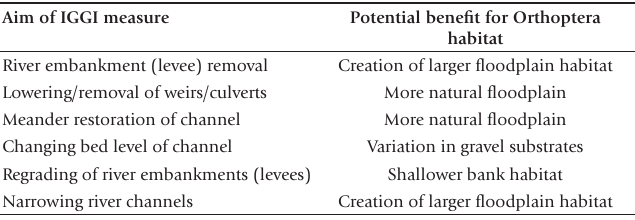
Fig. 6. Gravel floodplain along the Tama River, early successional habitat for the endangered Eusphingonotus japonicus grasshopper and Aster kantoensis . Photo by T. Gardiner. Table 4. Integrated Green Grey Infrastructure (IGGI) measures and their potential benefits for Orthoptera along rivers in Japan.